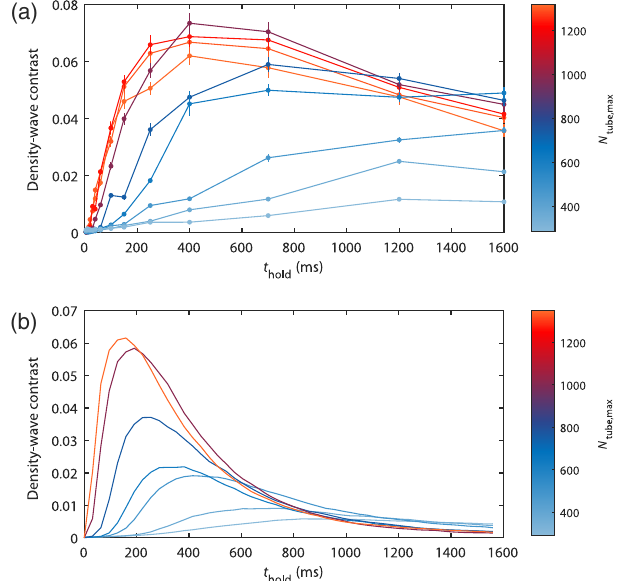
FIG. 13. Atom-number dependence. (a) Experimental density- wave order dynamics as a function of the initial atom number (color coded using the biggest tube population at t ∼ 0 ). The energy offset was Δ ¼ h × 1 . 4 kHz. All error bars correspond to the 68% confidence interval. (b) Simulation for the corresponding T=J ¼ 100 , without including atom parameters and k B